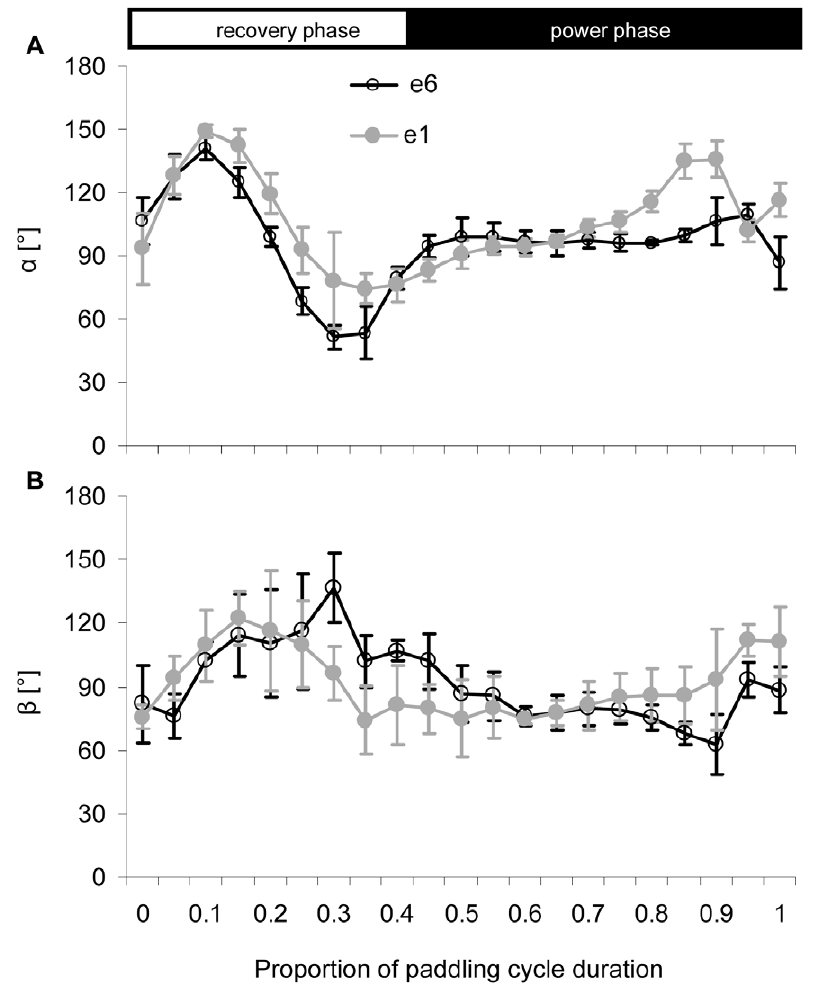
Figure 6. Orientation of the foot during paddling. The angles a (A) and b (B) between the span and chord of the foot respectively and the local relative velocity vector of the foot sections (See Figure 1 for identification of the angles and their notation). Only the angles for foot sections 1 (grey) and 6 (black) are shown. The horizontal axis is the same as in Fig. 4. The horizontal white and black rectangles at the top illustrate the division of the paddling cycle into the power and recovery phases. Data averaged from N=4 birds, 6 SD.